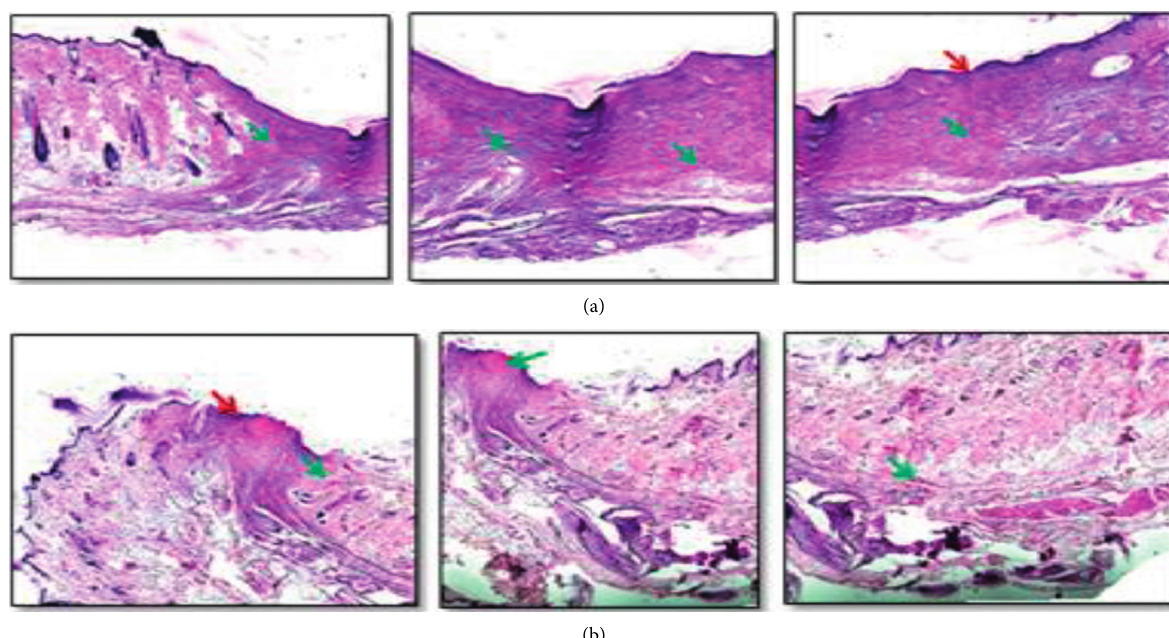
Figure 12: (a) Test (dHAM+TSP gel+coconut fiber) and (b) positive control (silicone gel membrane with silk suture): photomicrographs of H and E-stained images showing the wound edges and wound crater. Epithelialization is marked by a red arrow and collagen formation by green